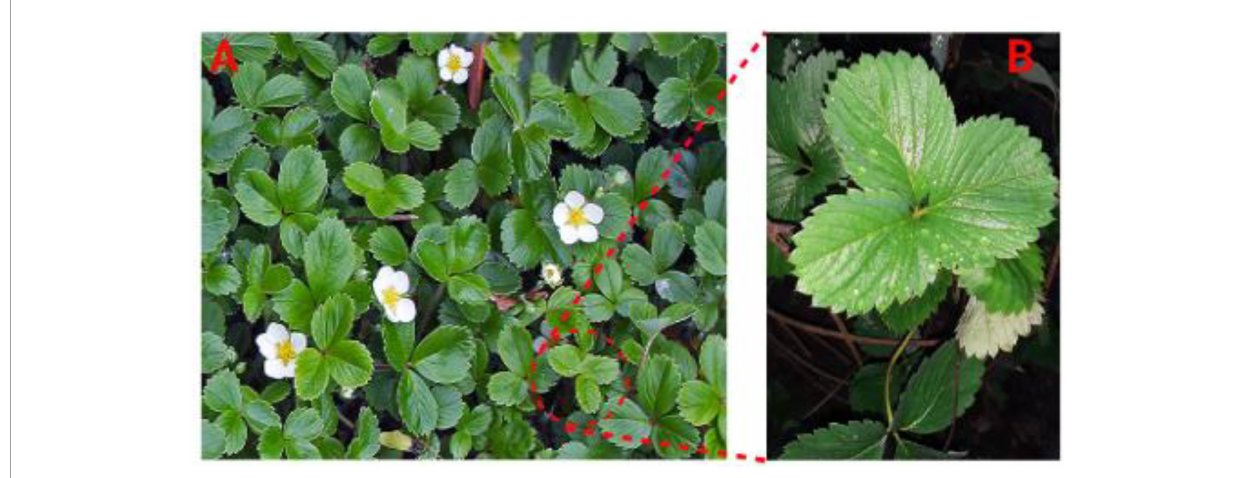
FIGURE1 (A) Fragaria genus ( Rosaceae family) strawberries ( Fragaria ananassa L.) plant; (B) Fragaria ananassa L. leaf extract using to biosynthesized